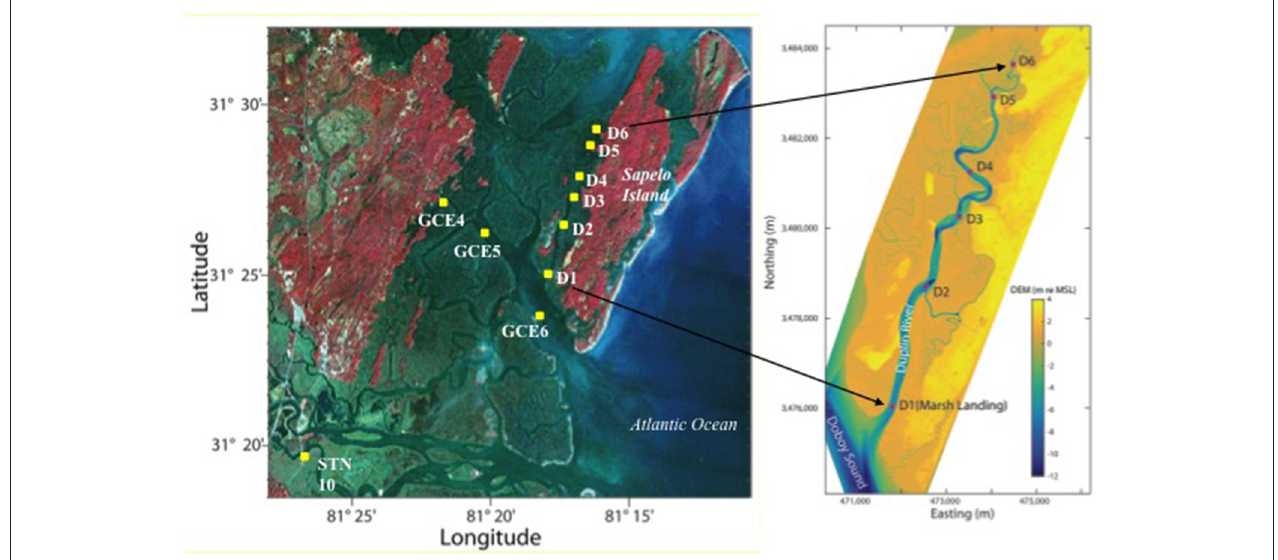
FIGURE 1 | Map of the sampling locations in the estuary of the Duplin River (D1–D6) sampled April–December 2014. Additional stations were regular sampling stations GCE 4–6 in the Doboy Sound and the freshwater end-member (STN 10) in the Altamaha River sampled in April 2014. Elevations in the DEM are in meters relative to mean sea level. DEM plot courtesy of Dr. Daniela Di